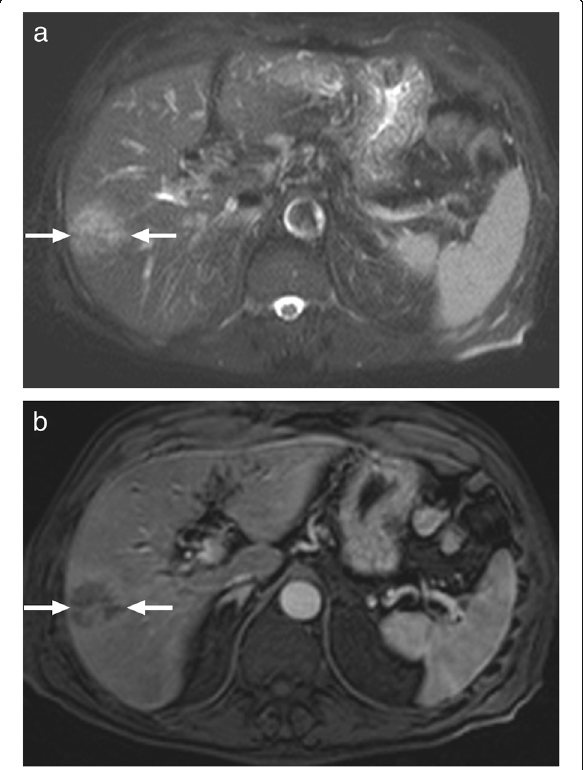
Fig. 19 A 70-year-old male with no significant past medical history presenting with focal hypoechoic liver mass on an US exam performed for new onset right upper quadrant pain. a Axial plane T2W image demonstrates moderately hypointense mass (arrows) in the right liver lobe. b Same lesion demonstrates mild peripheral enhancement with no significant central contrast filling (arrows). The